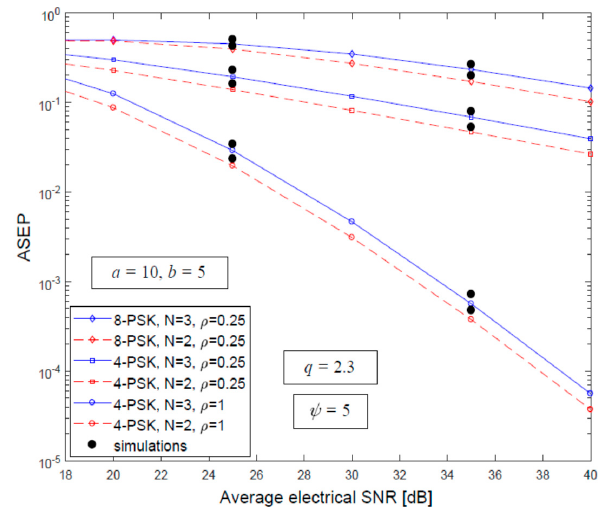
Figure 4. ASEP versus average electrical SNR of multi-hop FSO configurations for weak and strong turbulence strengths, a moderate amount of non-zero boresight pointing errors, and 4-PSK as well as 8-PSK modulation formats with weak phase noise impairments.